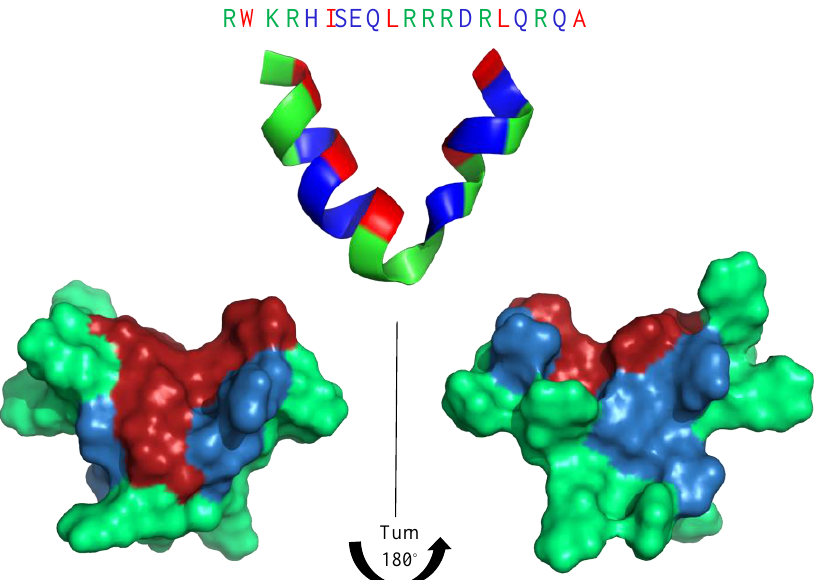
Figure 5. K30 structure calculated with I-Tasser. Amino acids are colored in red (hydrophobic), blue (hydrophilic), and green (positively charged).